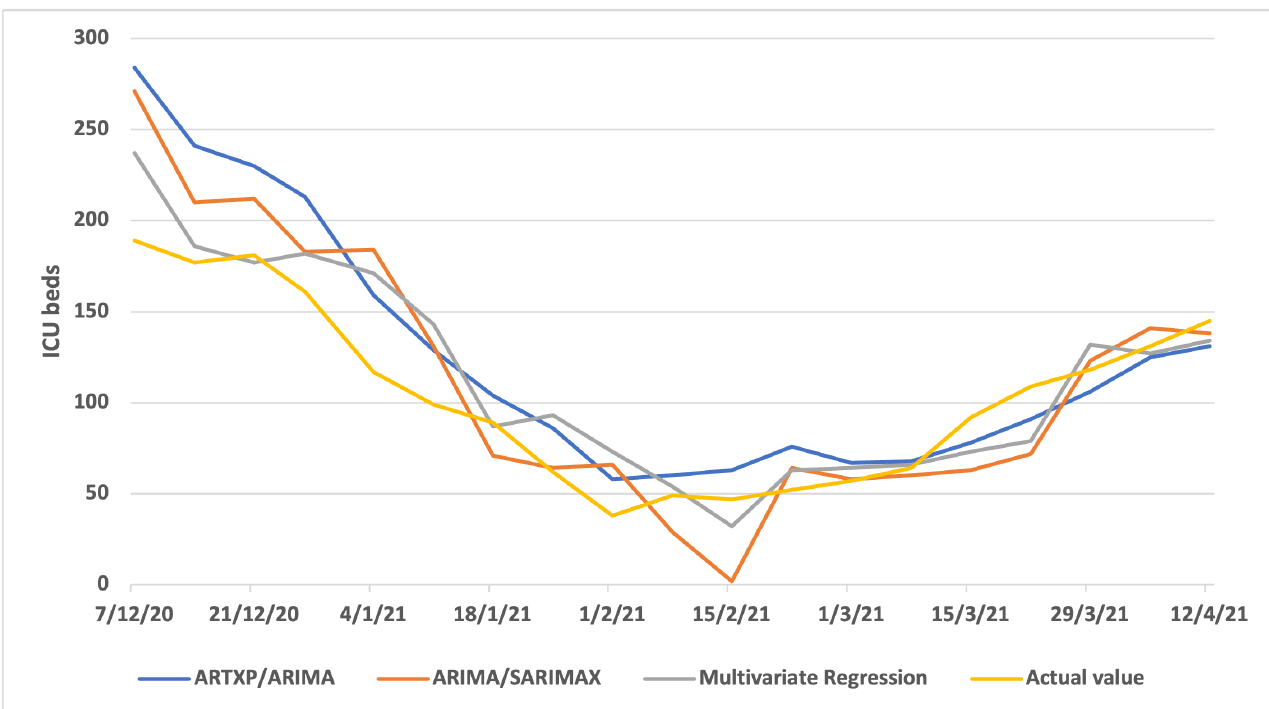
Figure A1. One week Predicted vs. Actual ICUs—Thessaloniki.